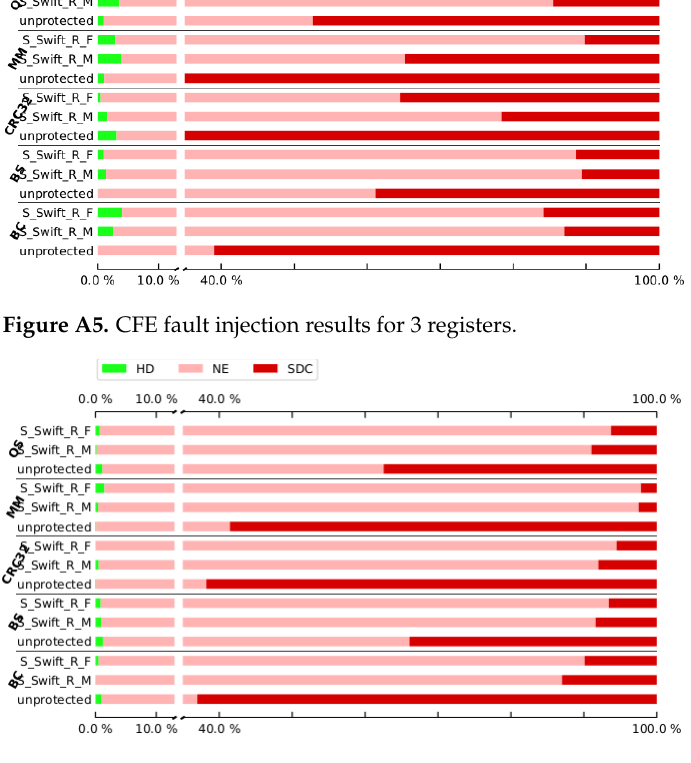
Figure A6. DFE fault injection results for 3